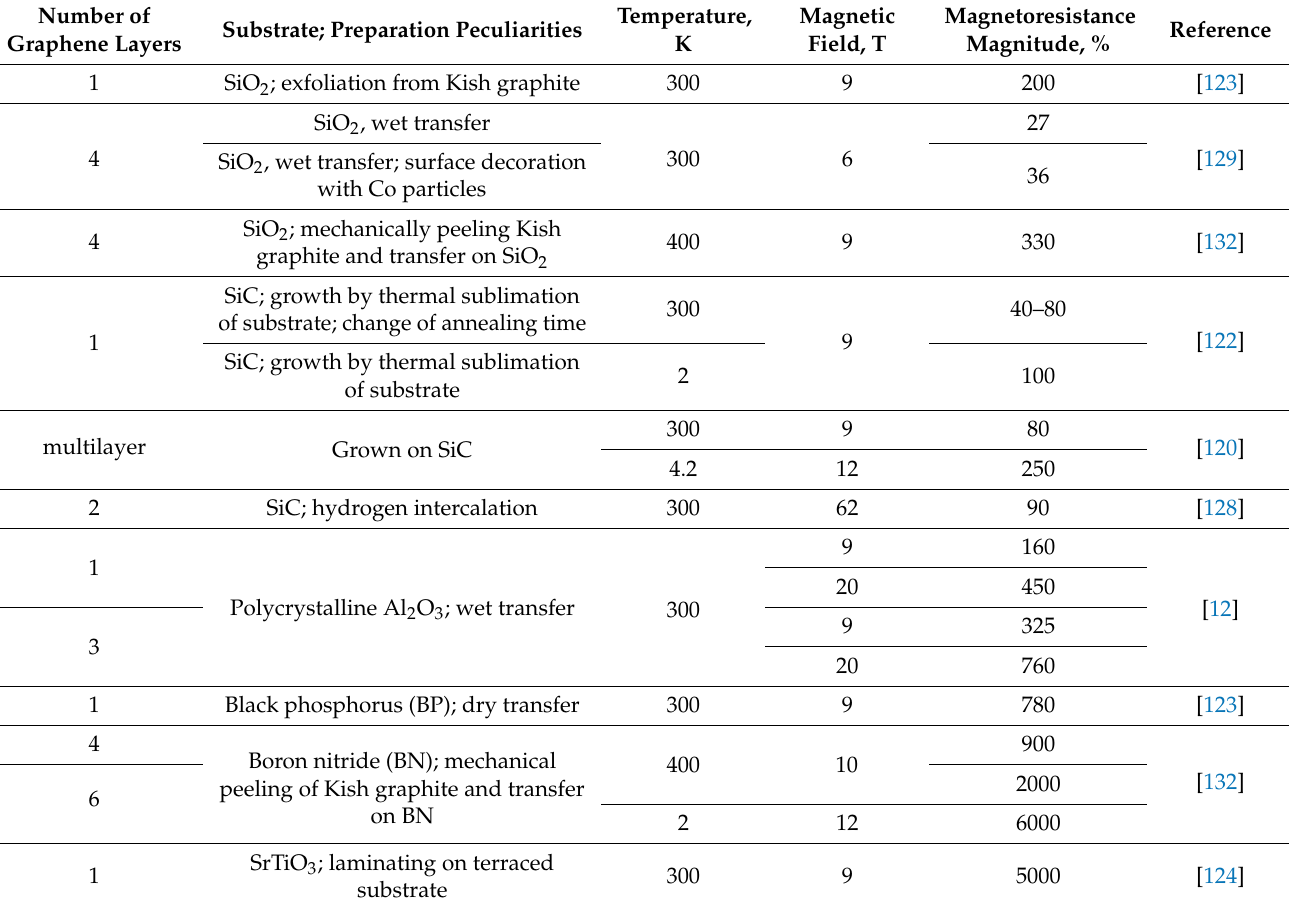
Table 2. Some examples of magnetoresistance magnitude in single, few-layer and multi-layered graphene measured at low and room temperatures in high magnetic